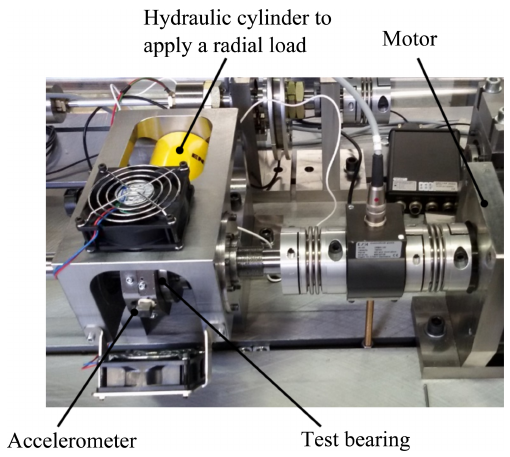
Figure 3. The indentation at the bearing inner race was used as the start condition, and the surface fatigue fault at the inner race was introduced by the accelerated lifetime